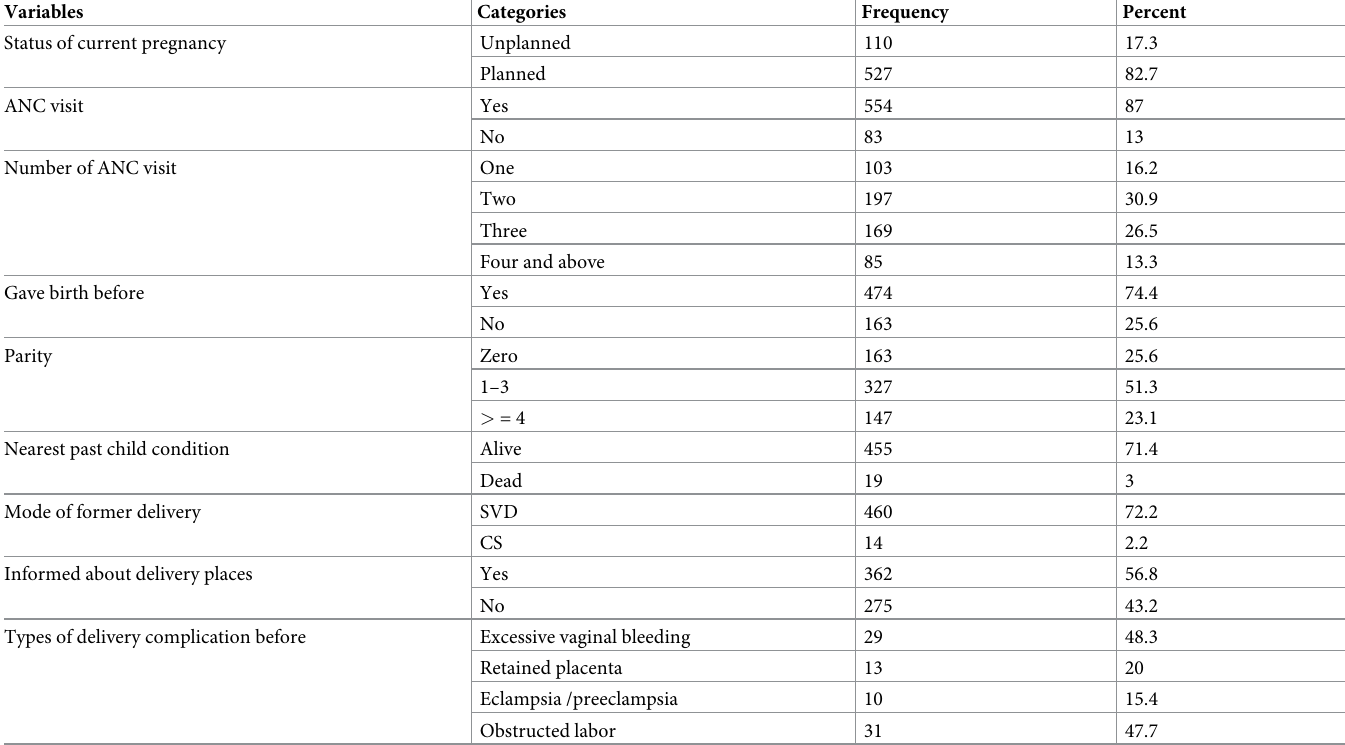
Table 2. Obstetric characteristics of pregnant women in Yilmana Densa district, northwest Ethiopia, 2020 (n =